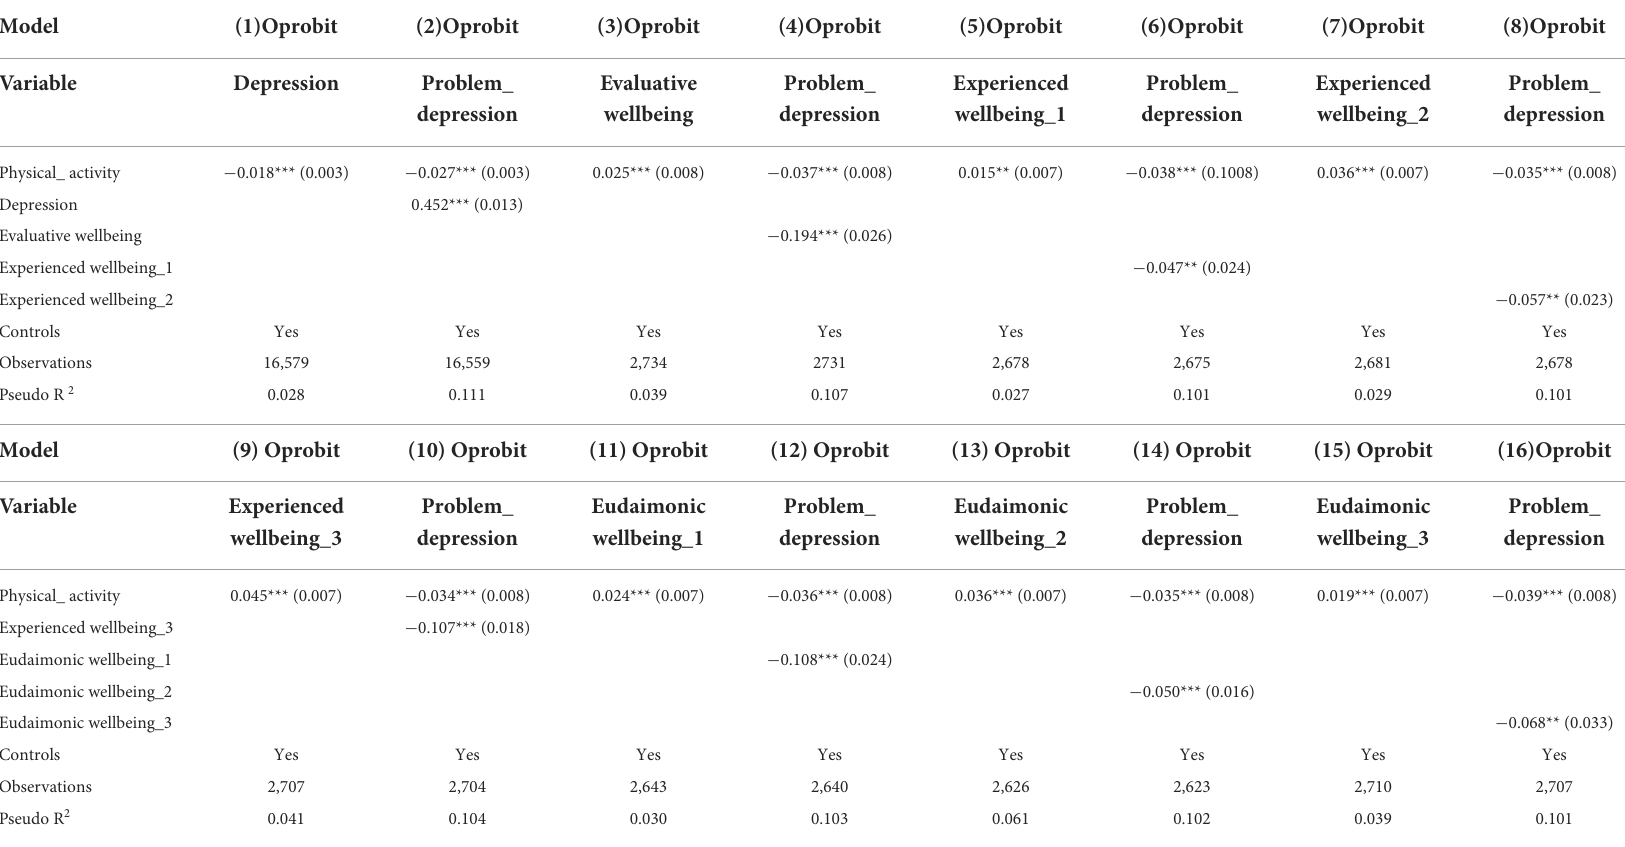
TABLE 2 Mechanism